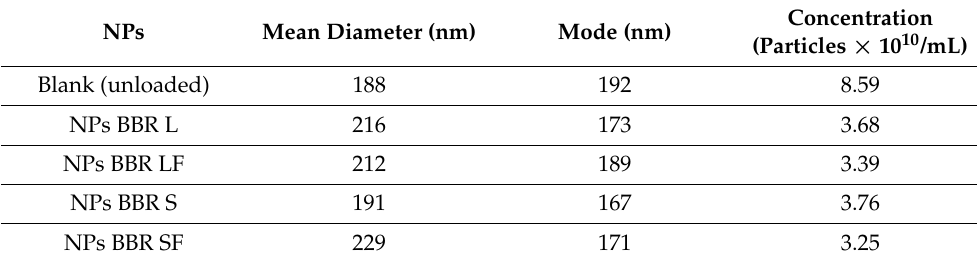
Table 2. Size and concentration data of all considered NP formulations.